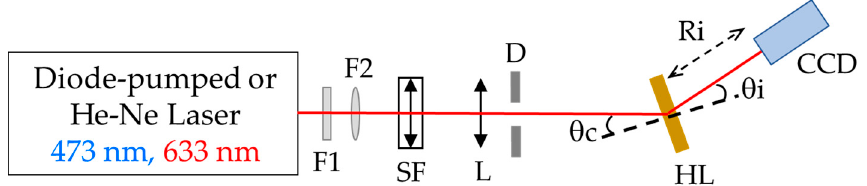
Figure 3. Experimental setup for the evaluation of holographic lenses. Fi: filters, SF: spatial filter, L: